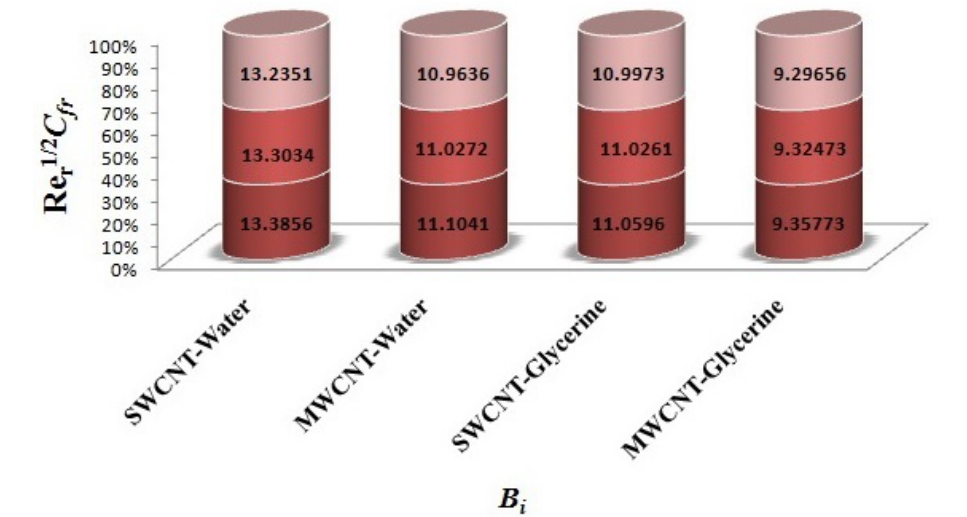
Figure 28. Impact of B i on Skin-friction.